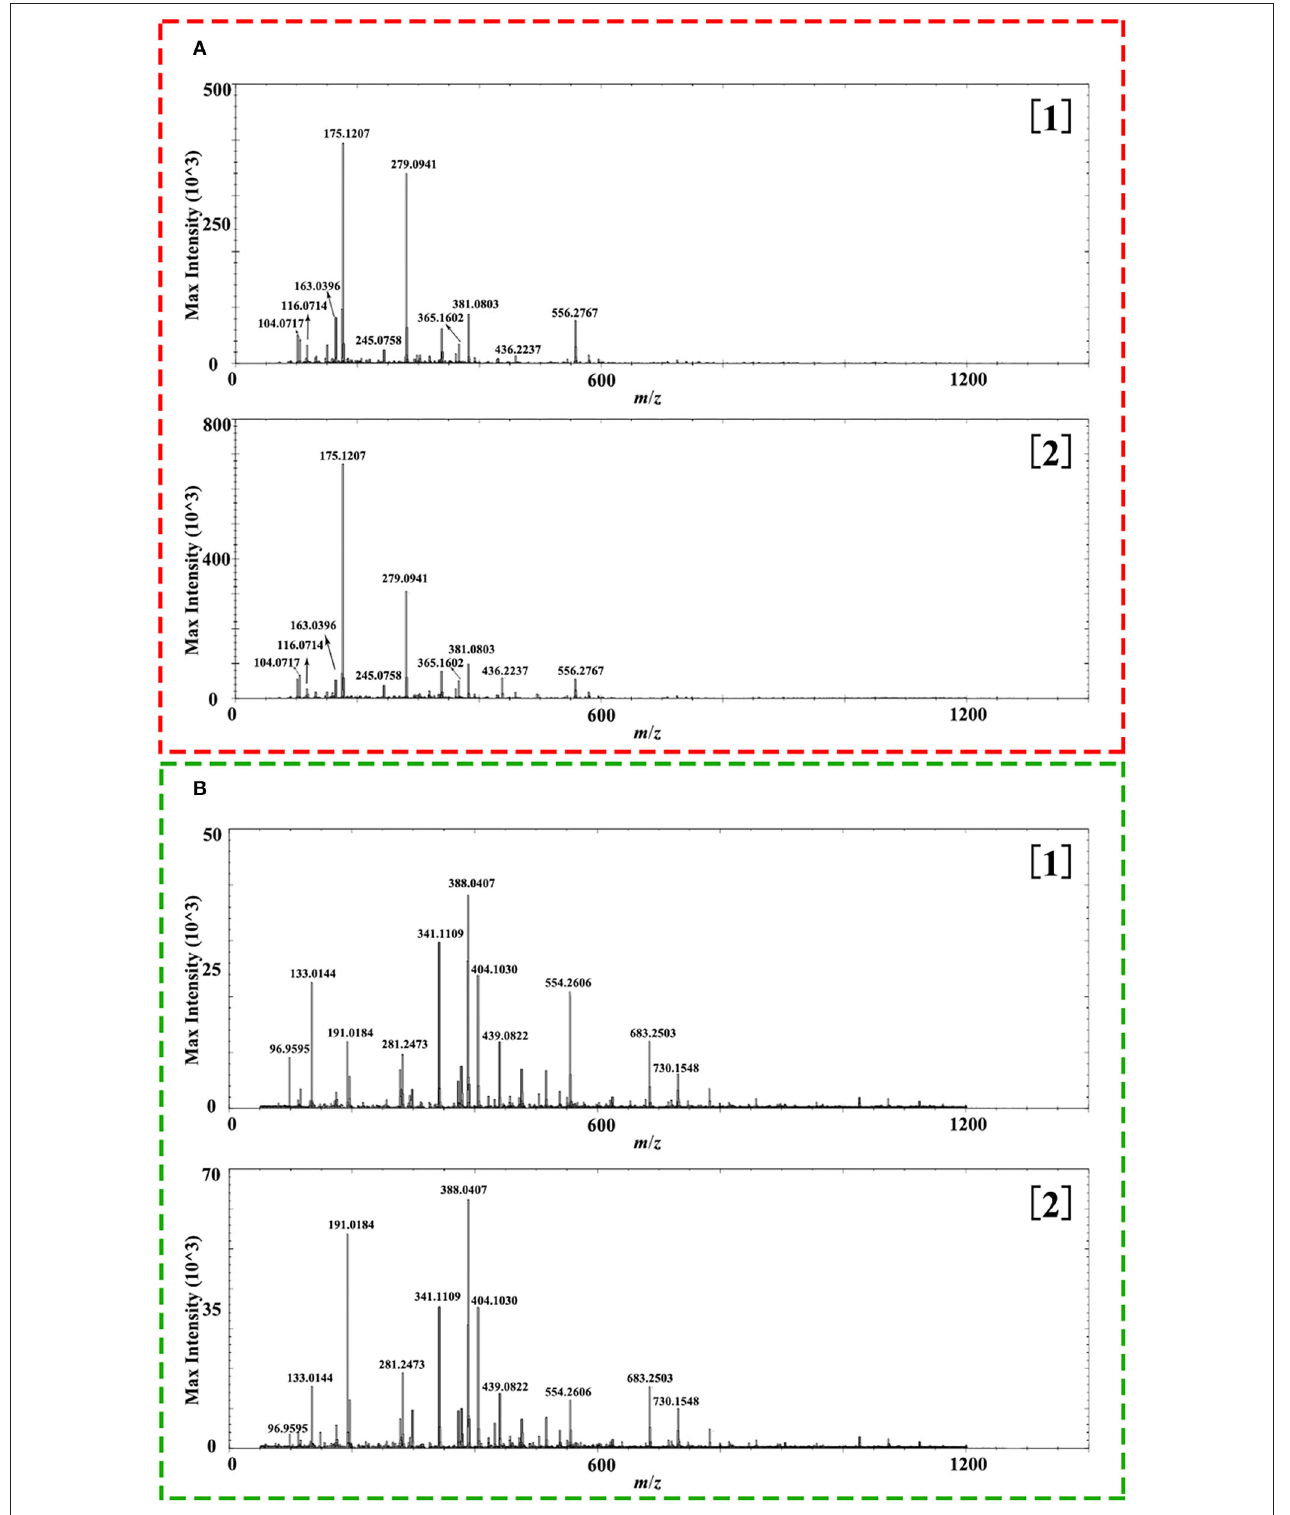
FIGURE 5 | Representative overall average mass spectra acquired from wood ([1]) and bark ([2]) of the cross section of Isatidis Radix by desorption electrospray ionization and quadrupole-time-of-flight (DESI-Q-TOF) mass spectrometry imaging (MSI) in the spectral ranges of m / z 50–1,200 under positive (A) and negative (B) ionization